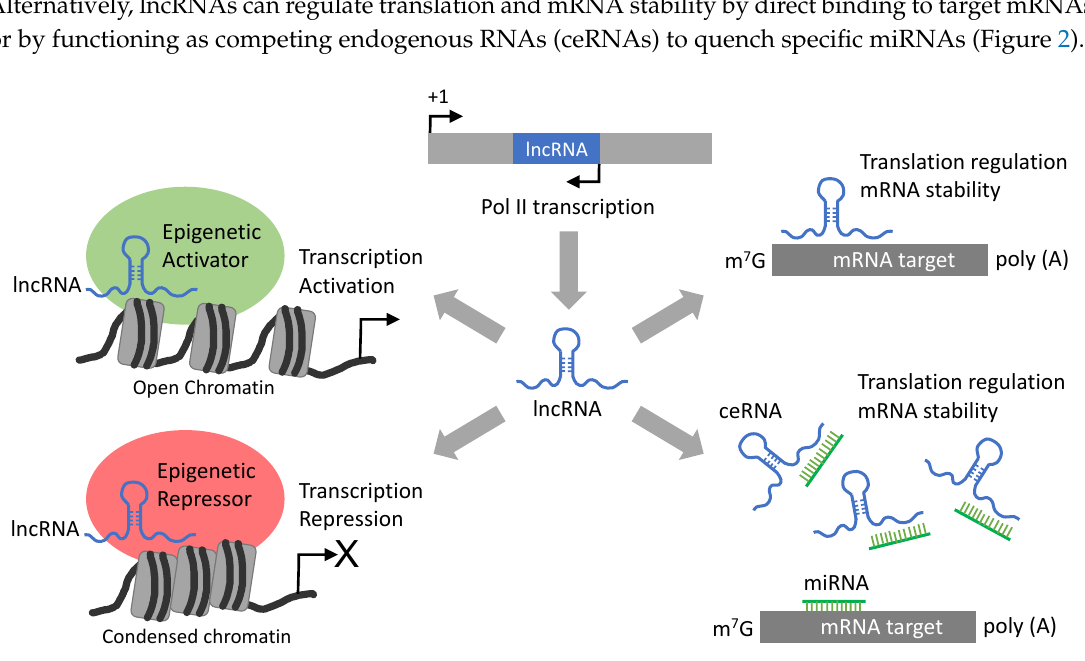
Figure 2. Long non-coding RNA (LncRNA)-mediated gene regulation mechanisms. Generally, lncRNAs originate from antisense transcripts produced by RNA polymerase II (Pol II). LncRNAs can be produced from diverse genomic locations, including introns, coding regions and sequences between genes. LncRNAs can recognize specific mRNA targets to modulate their expression by a ff ecting post-transcriptional processes, including translation and mRNA stability. Alternatively, lncRNA can recruit proteins such as epigenetic regulators (activators or repressors) as a sca ff olding system guided to regulate the expression of specific target genes. Additionally, lncRNAs can regulate specific